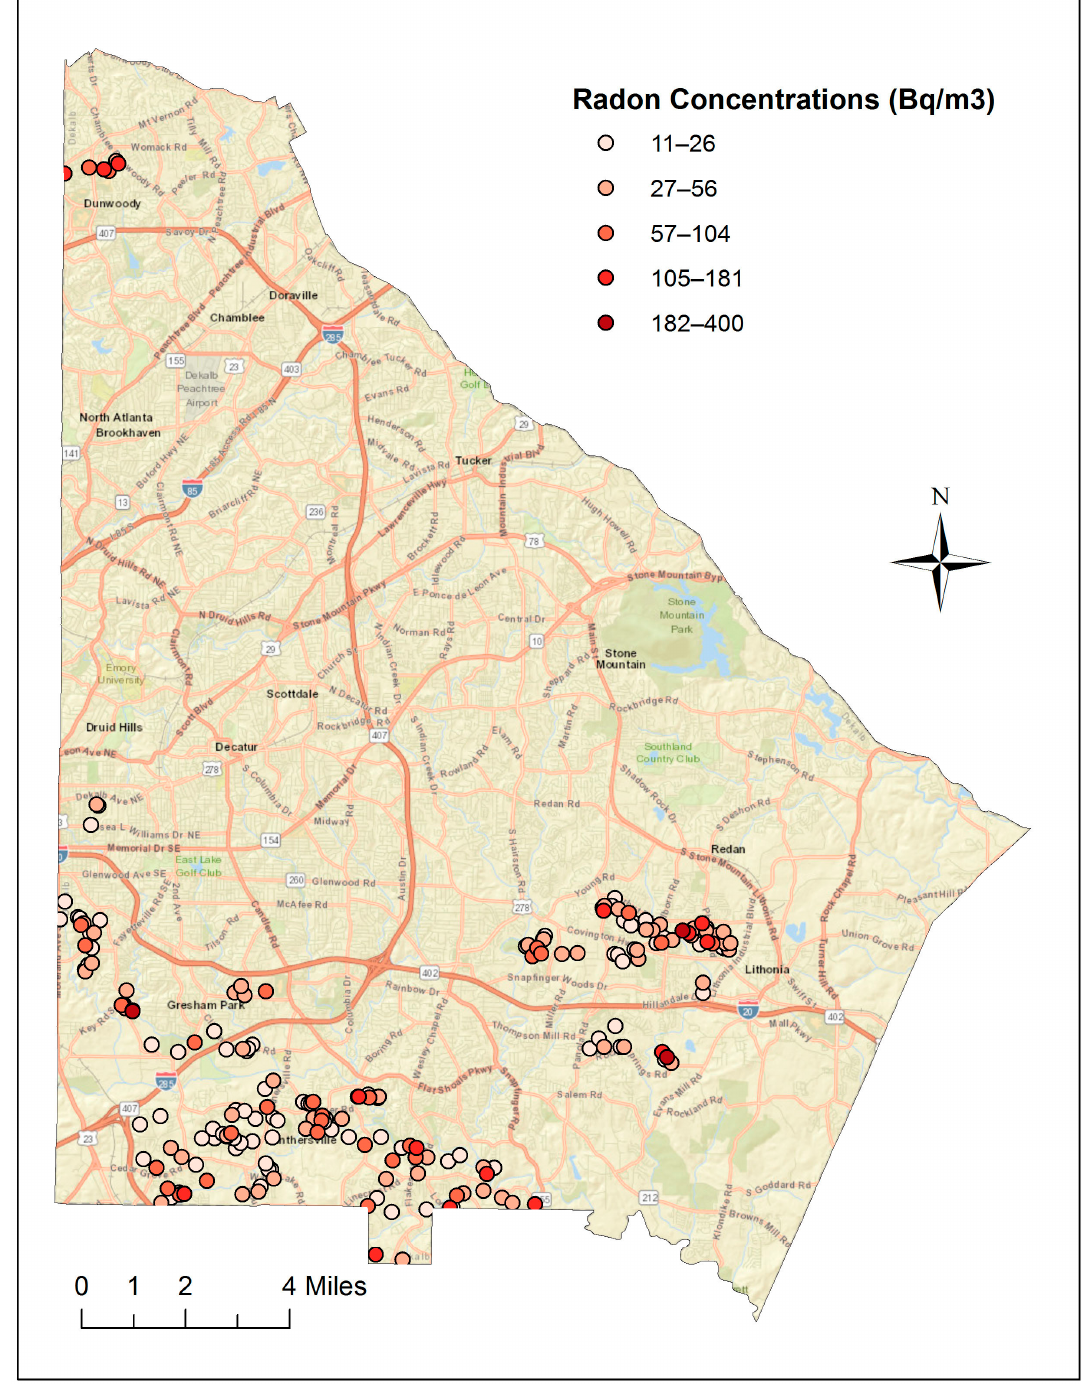
Figure 2. Graduated colors representing radon concentrations for each sample location within the 14 sampled tracts of DeKalb County, GA, in 2015.